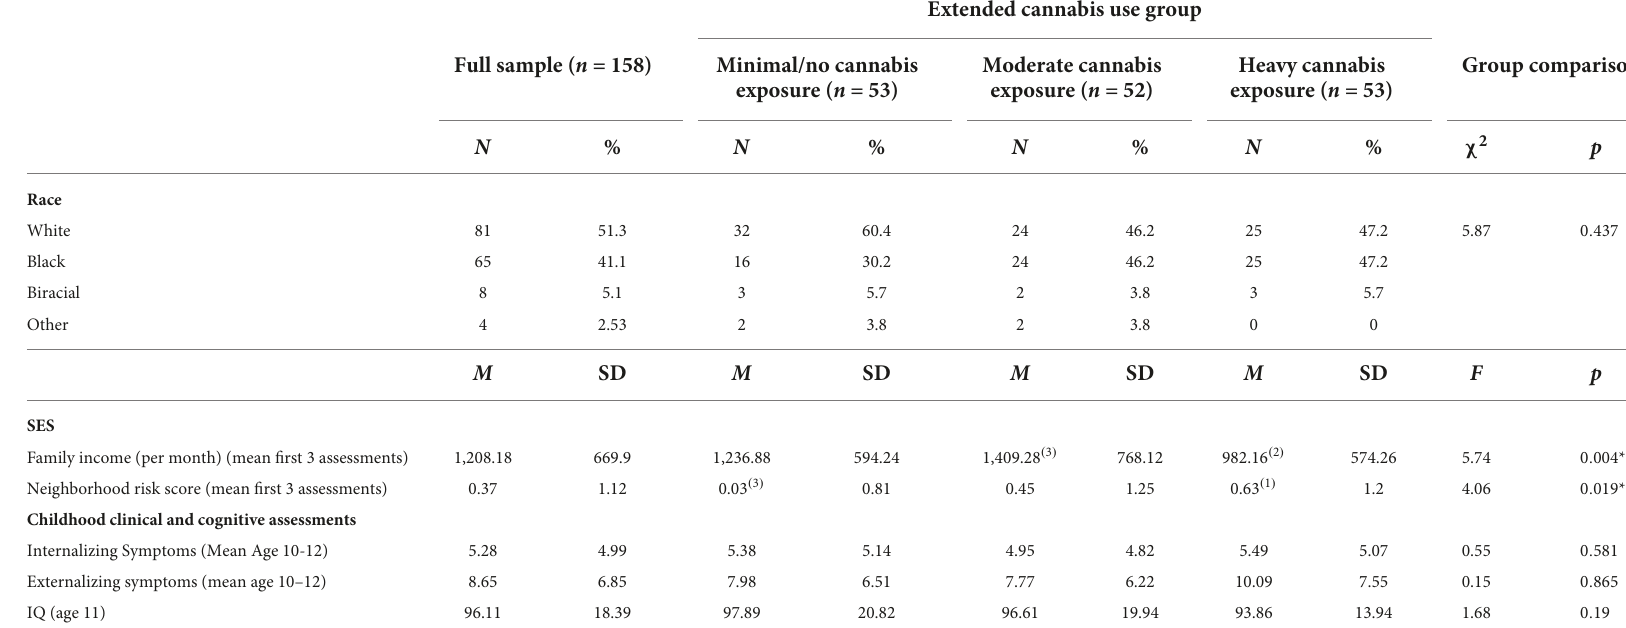
TABLE 1 Sample demographic and clinical